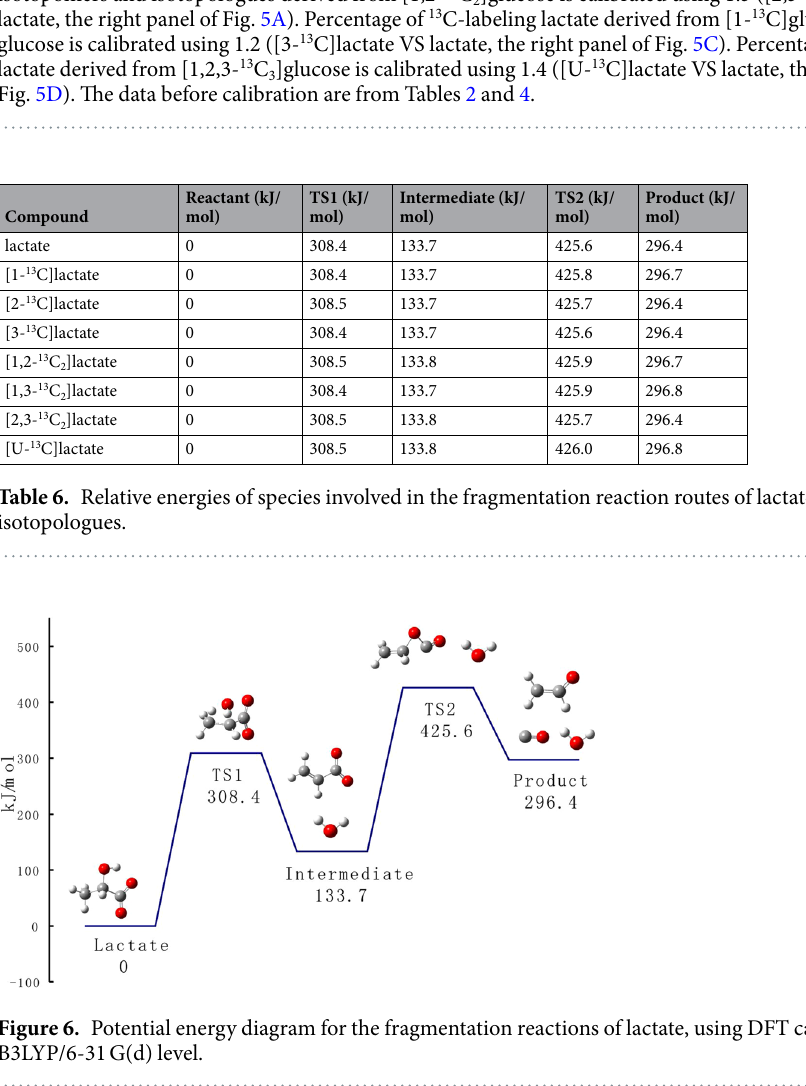
10 SCIENtIFIC RepoRts | 7: 8489 | DOI:10.1038/s41598-017-08277-3